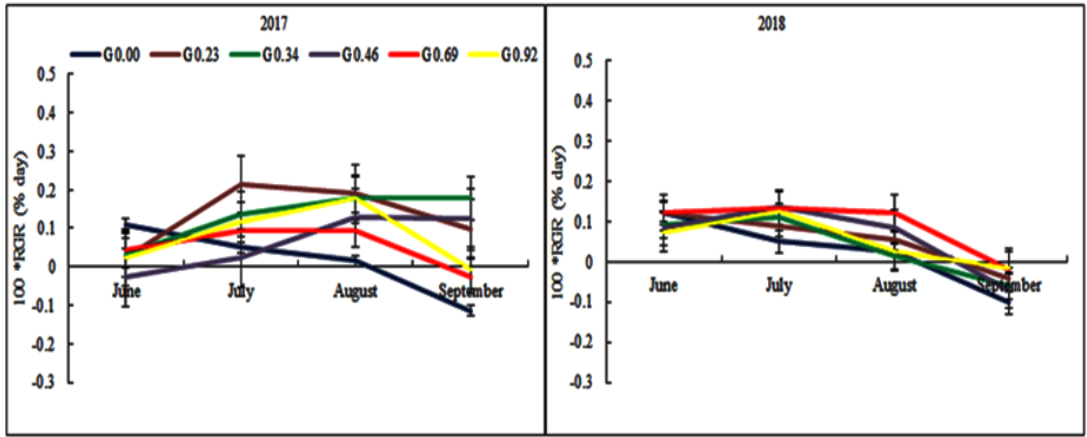
Figure 7. E ff ect of grazing intensity and season on relative growth rate (RGR). Figure 7. Effect of grazing intensity and season on relative growth rate (RGR).